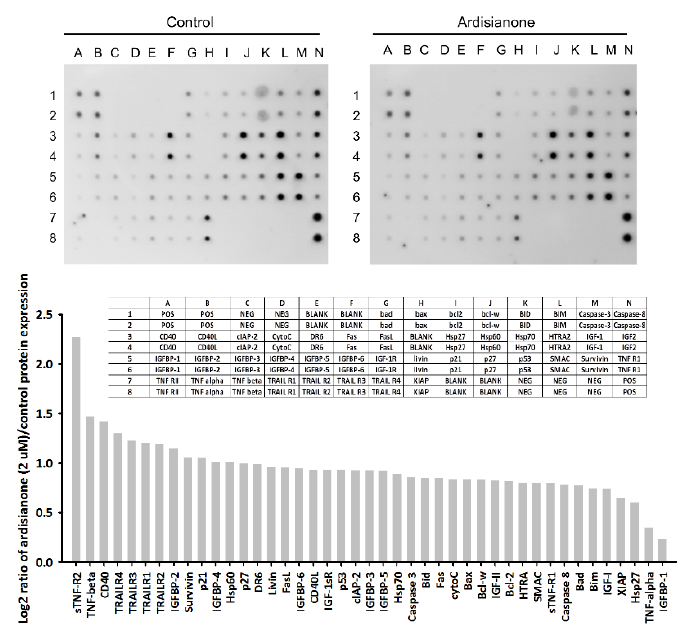
Figure 2. Protein array analysis of ardisianone-treated cells. HL-60 cells were incubated in the absence or presence of ardisianone (2 µ M) for 9 h. The cells were lysed, and equal amounts of protein from each sample were used for the assay. Quantitative analysis in the arrays showed differences in the apoptotic marker proteins. All the protein levels were normalized in the positive dots.